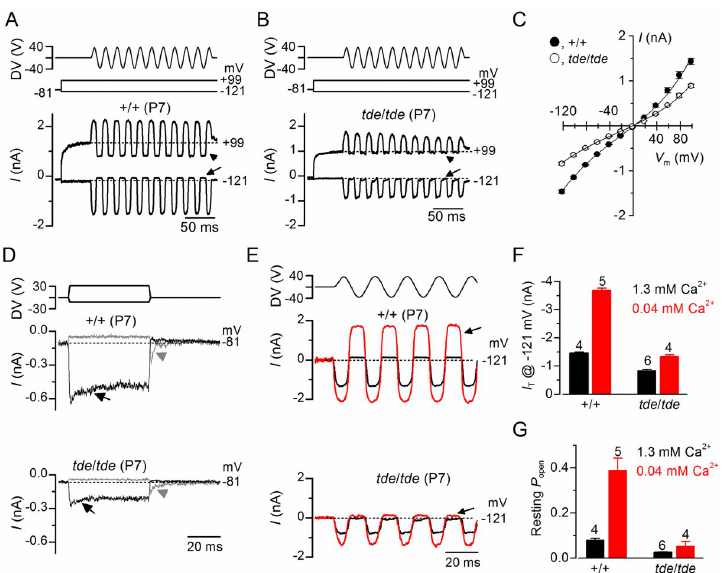
Fig 5. Mechanoelectrical transducer currents in Tasmanian devil inner hair cells. A and B , Saturating transducer current recordings from an apical-coil control ( A ; +/+) and a mutant ( B ; tde / tde ) P7 OHC in response to a sinusoidal force stimulus of 50 Hz to the hair bundles. The fluid jet driver voltage (DV) of ± 40 V is shown in the top panels (negative deflections of the DV are inhibitory). OHC membrane potential was held at − 81 mV and depolarized in 20 mV increments from − 121 mV (for clarity only responses to − 121 mV and +99 mV are shown). The arrows and arrowheads indicate the closure of the transducer channels, i.e. disappearance of the resting current, during inhibitory bundle displacements. Dashed lines indicate the current at the different test potentials. Note that there is no or very little resting transducer current in the tde / tde OHC at either potential. In controls the resting current increases with membrane depolarization. C , Peak-to-peak transducer current-voltage curves were obtained from 4 control and 5 mutant OHCs (P7) in 1.3 mM extracellular Ca 2+ . The data were fit according Eq 2 (see Methods) with values: control k = 405 ± 25, V r = 0.1 ± 0.5 mV, V s = 40 ± 2 mV, and γ = 0.43 ± 0.01; mutant k = 266 ± 23, V r = -2.1 ± 1.0 mV, V s = 43 ± 3 mV, and γ = 0.43 ± 0.01. D, Step deflections of the OHC hair bundle (fluid jet driver voltages are shown in the top panel) elicited transducer currents recorded at –81 mV from a control (+/+) and a mutant ( tde / tde ) OHC. Excitatory bundle deflection (positive DV) elicited inward transducer currents that declined or adapted over time in control and mutant OHCs (black arrows). Inhibitory bundle deflection (negative driver voltage and grey current traces) turned off the resting transducer current (indicated by the dashed lines) in control cells but this was almost negligible in tde / tde cells. The transducer current in both control and mutant OHCs showed evidence of rebound adaptation (grey arrowheads) upon termination of the inhibitory stimulus. E , Saturating transducer currents recorded at a holding potential of − 121 mV (fluid jet driver voltage above) from a control (+/+) and a mutant ( tde / tde ) OHC in the presence of 1.3 mM (black traces) and 0.04 mM (endolymph-like; red traces) extracellular Ca 2+ . For comparison the baseline current has been zeroed in both cells so the resting transducer current is now the difference between zero (dashed line) and the positive current during negative bundle stimulation (arrows). F and G , Maximal transducer current size at the membrane potential ( F ) and resting transducer channel P open ( G ) at − 121 mV in control and tde / tde OHCs in the presence of 1.3 mM and 0.04 mM extracellular Ca 2+ . Resting P open was calculated as the ratio between resting and maximal transducer currents. Recordings were made at room